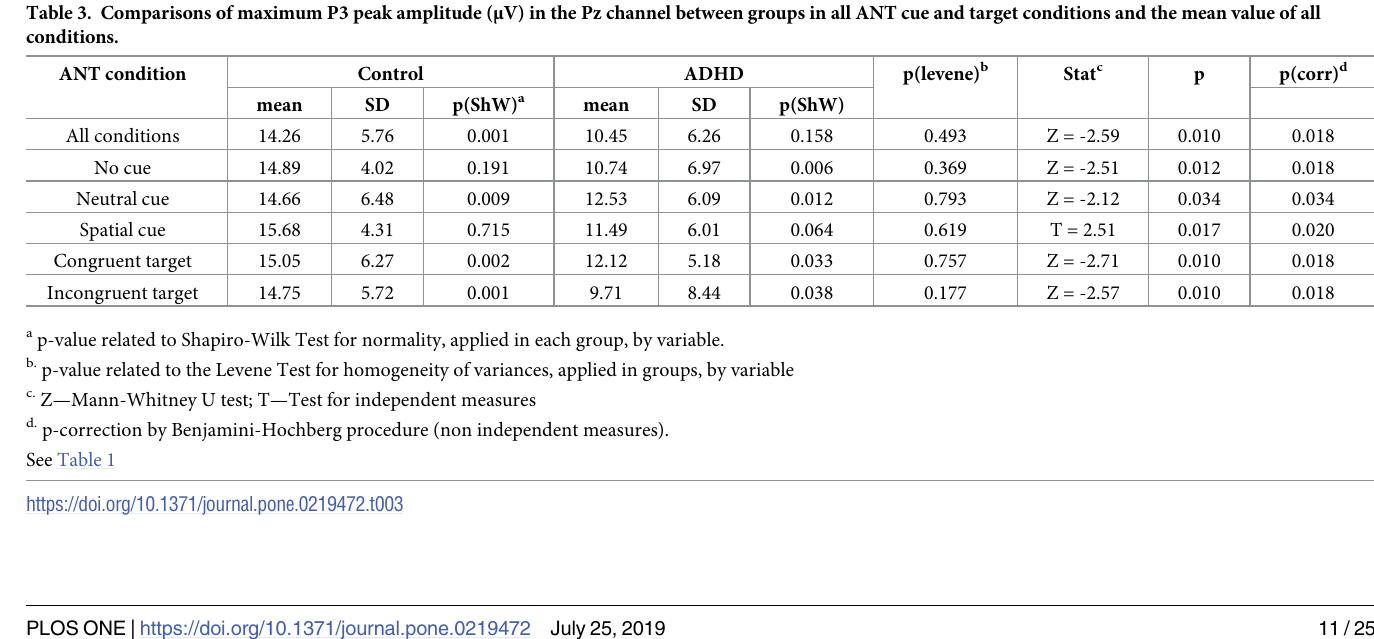
Hyperactivity + Impulsivity